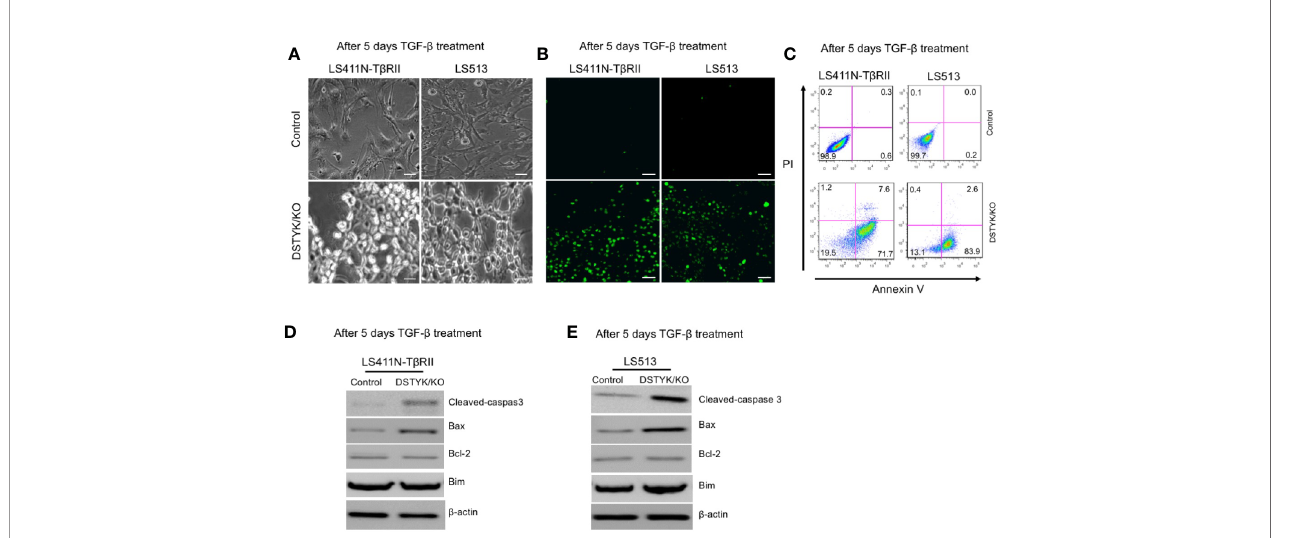
FIGURE 4 | TGF- b induces apoptosis in the absence of DSTYK. (A) Morphological differences between control cells and DSTYK/KO cells after 5 days TGF- b treatment. (B) TUNEL assays to detect the apoptotic signals in control cells and DSTYK/KO cells after 5 days TGF- b treatment. The green color indicates DNA fragmentation. Scale bar, 100 m m. (C) Flow cytometry analysis to compare the levels of cell death by staining with cell surface apoptotic marker annexin V and the necrotic marker PI in control and DSTYK/KO cells after 5 days TGF- b treatment. Western blot analysis of apoptosis-related proteins including cleaved-caspase-3, Bcl-2, Bim, and Bcl2-associated X (Bax) in control and DSTYK/KO LS411N-T b RII cells (D) and LS513 cells (E) after 5 days TGF- b treatment. b -actin is used as loading control. All experiments were repeated for at least three times, and similar results were